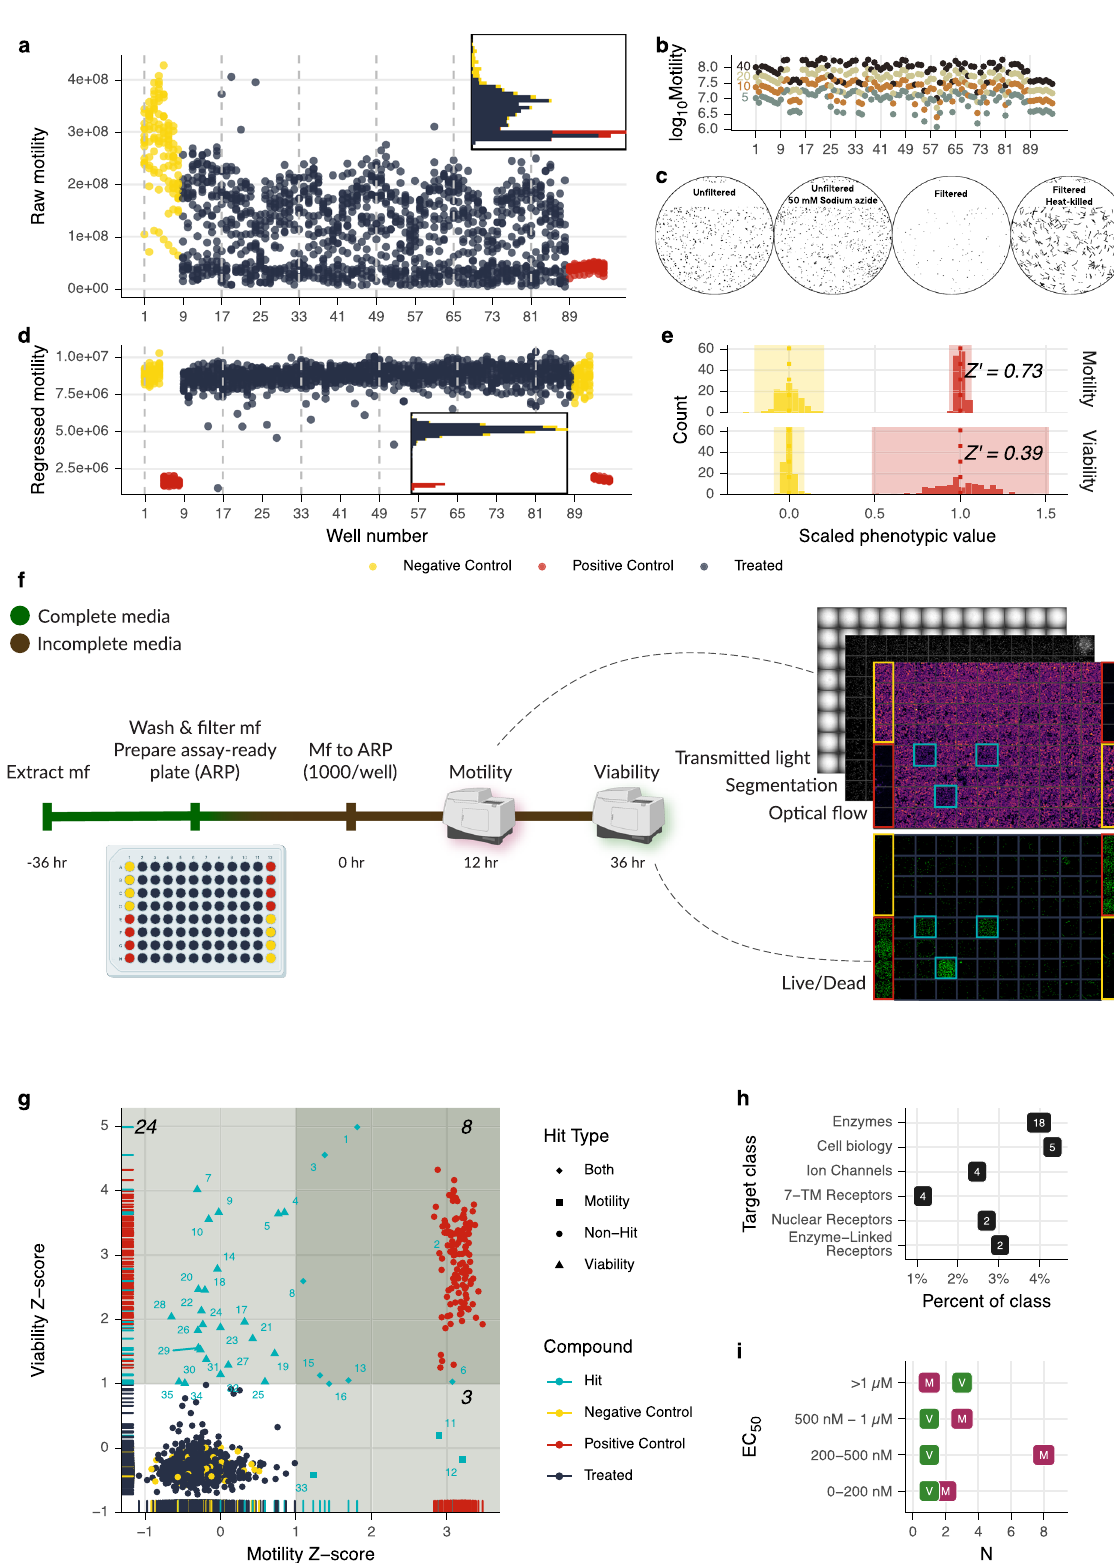
These two compounds caused substantial motility and viability effects ( Z Viability > 4.5, Z Motility > 1.3), suggesting that our primary screen had some predictive power for compound potency. Eleven of the top 15 hits from the primary screen were recapitulated with <1 µM EC 50 values, while only 3 of the bottom 22 hits produced a measurable EC 50 for any of the phenotype/time